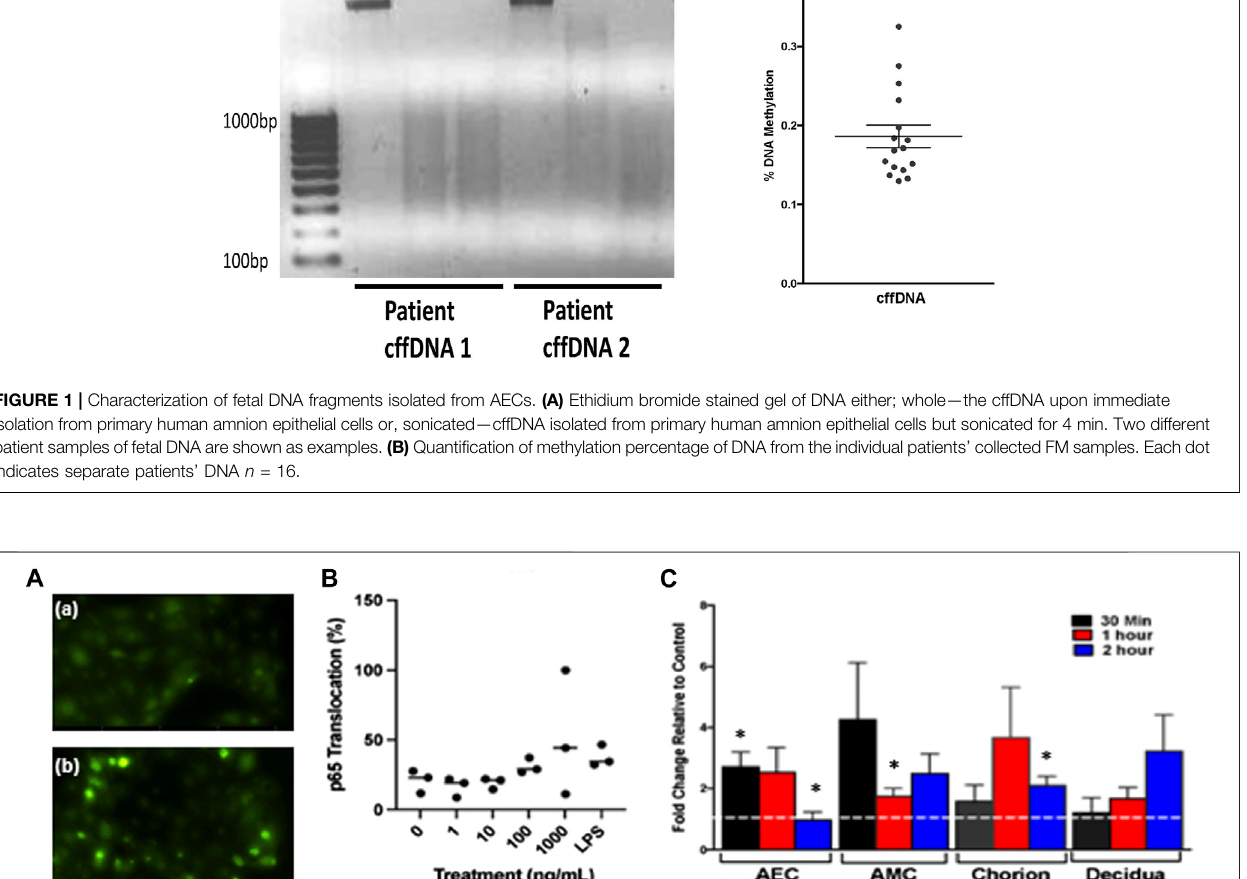
Frontiers in Physiology |